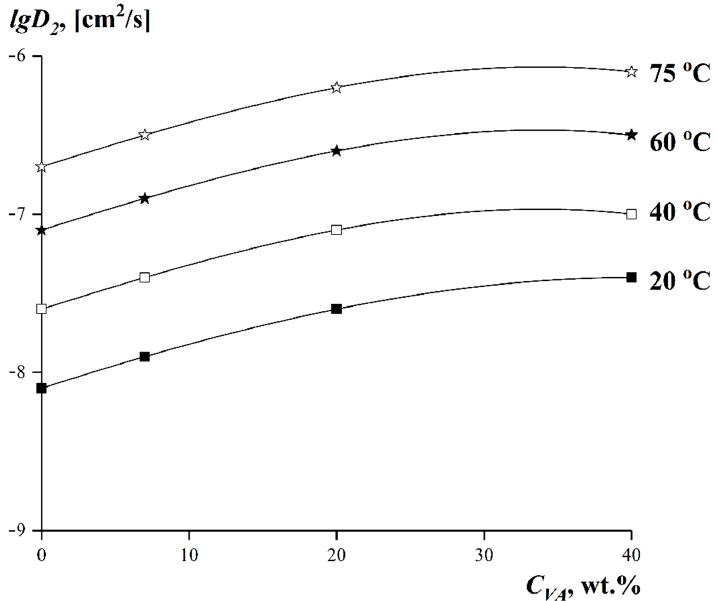
Figure 10. Dependences of the limiting interdiffusion coefficient at ϕ tBA → 0 on the VA content in EVA. Temperatures are indicated in the figure.